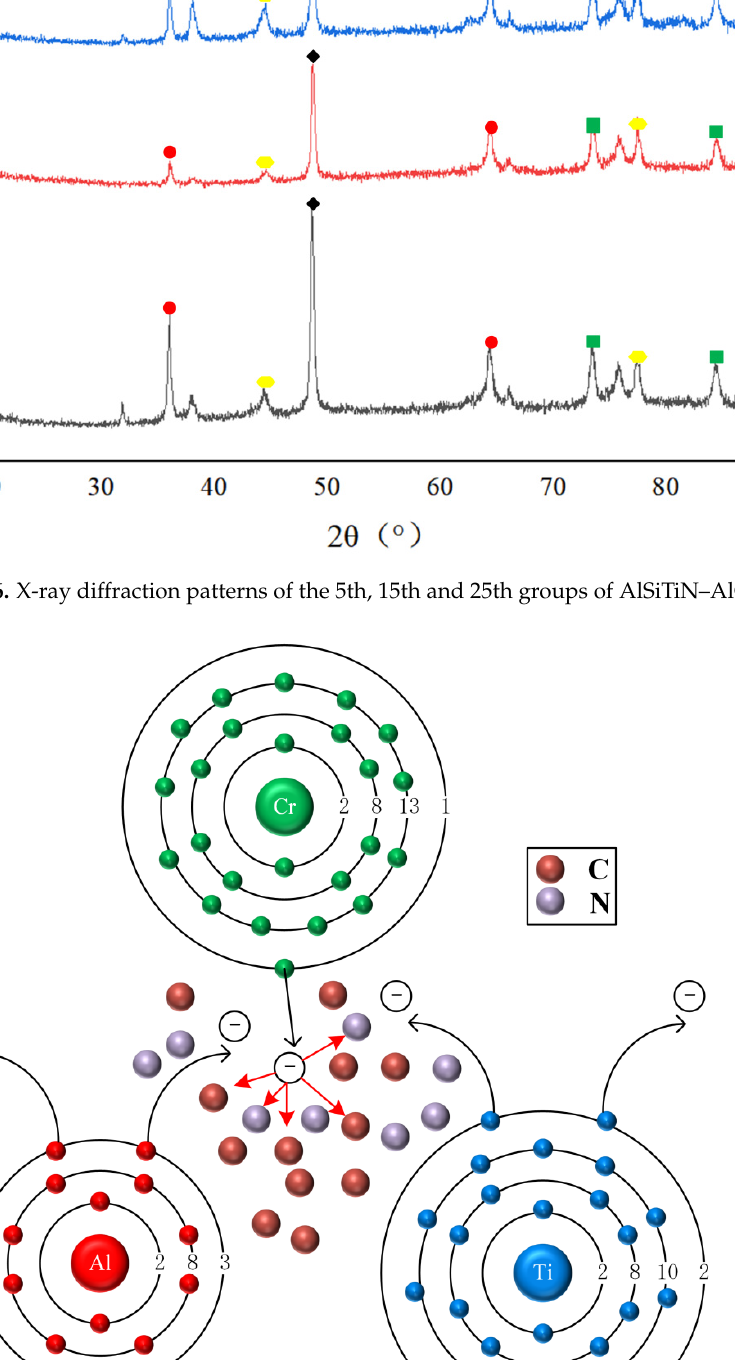
Figure 7. Schematic diagram of gain and loss of electrons of Al, Ti and Cr in the coating structure. The XRD energy spectrum was analyzed by Jade 5.0 software, and the peak height, peak half width, X-ray wavelength and di ff raction angle of each di ff raction peak were obtained. And according to the Equation (1) [15]: 𝑘𝜆 𝐷 = (1) 𝛽𝑐𝑜𝑠𝜃 where k is a constant; λ is X-ray wavelength, (nm); β is the half width and height of the di ff raction peak, (nm); θ is the di ff raction angle, (°); D is grain size, (nm). The value of k is related to the de fi nition of β , usually 0.89. The constant k , X-ray wavelength λ and di ff raction angle θ are fi xed values. When the half width and height β increase, the grain size D decreases. It can be seen from Figure 8 that the addition of Cr element increases the full width at half maximum of AlN and WC peaks, so the grain size of AlN and WC decreases and the crystal strength increases. Figure 8. The half width and height of WC and AlN peaks change after adding Cr element. Since the atomic radius of Cr is larger than that of Al, the sign of the mis fi t degree of Al and Cr in the matrix is opposite. Al reduces the distortion energy in the matrix so that the tendency of these atoms to segregate at grain boundaries and other regions is reduced. Al has slightly lower segregation energy than Cr, indicating that Al occupies the grain